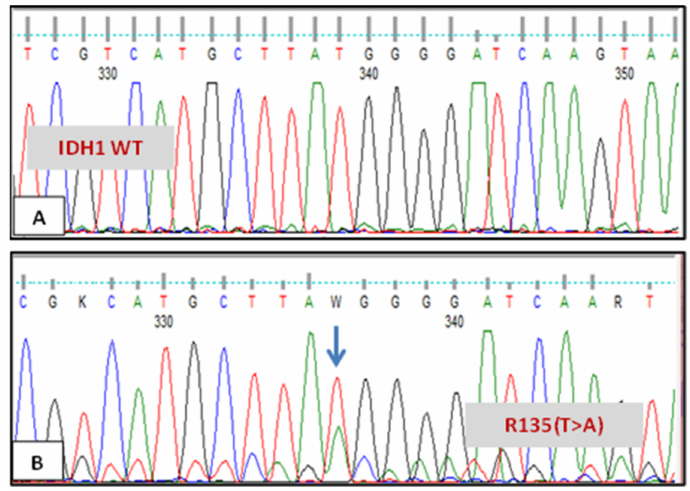
Figure 3. Sequencing chromatogram of IDH1 in two different patients. ( A ) Patient with normal IDH1 sequence at codon R135. ( B ) Patient with IDH1 mutation at codon R135